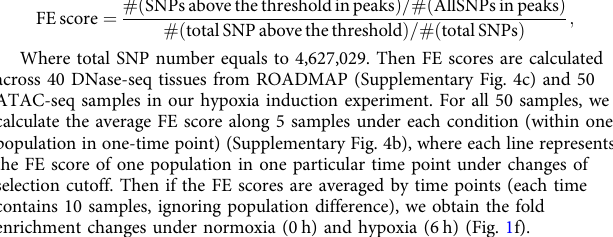
regions. The aim is to choose the right cell type and condition for GWAS variants interpretation and then generate multi-omics data in this condition. This step is extremely important when regulatory elements are functional in dynamic contexts. We calculate fold enrichment (FE score of selection SNPs in functional genomic regions. For each SNP set under a certain cutoff (for example, 111,182 SNPs are under selection with FDR p <0.05), we calculate their fold enrichment score de fi ned by the following formulation.